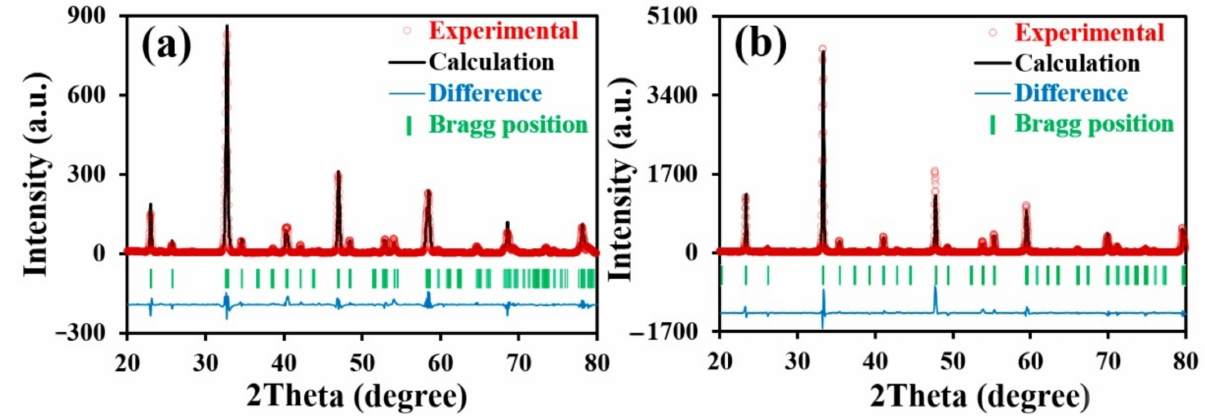
Figure 1. Rietveld refinement results for the PrNi 0.4 Fe 0.6 O 3– δ ( a ) and PrNi 0.4 Co 0.6 O 3– δ ( b ) at room temperature.